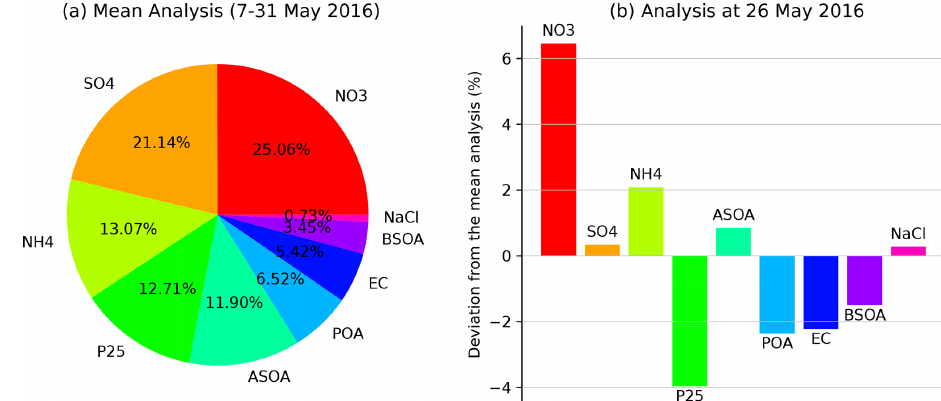
Figure 8. (a) Pie chart showing the percentage contribution by aerosol species in Seoul, South Korea, in the analysis averaged over 97 cycles from 00:00UTC on 7 May to 00:00UTC on 31 May 2016 and (b) deviations from the mean analysis in the analysis at 00:00UTC on 26 May 2016 over domain 2 in the DA experiment. Surface PM 2 . 5 consists of aerosol sulfate (SO 4 ; so4ai and so4aj), ammonium (NH 4 ; nh4ai and nh4aj), nitrate (NO 3 ; no3ai and no3aj), primary organic matter (POA; orgpai and orgpaj), elemental carbon (EC; eci and ecj), unspeciated PM 2 . 5 (P25; p25ai and p25aj), sodium chloride (NaCl; naai, naaj, clai, and claj), and four-bin anthropogenic and biogenic secondary organic aerosol (ASOA and BSOA, respectively) at the lowest model level.